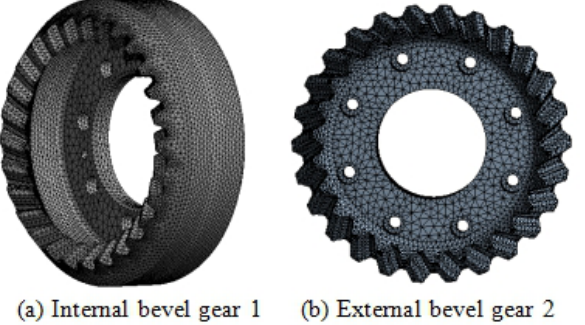
Figure 7. The mesh models of double circular arc spiral bevel gears.